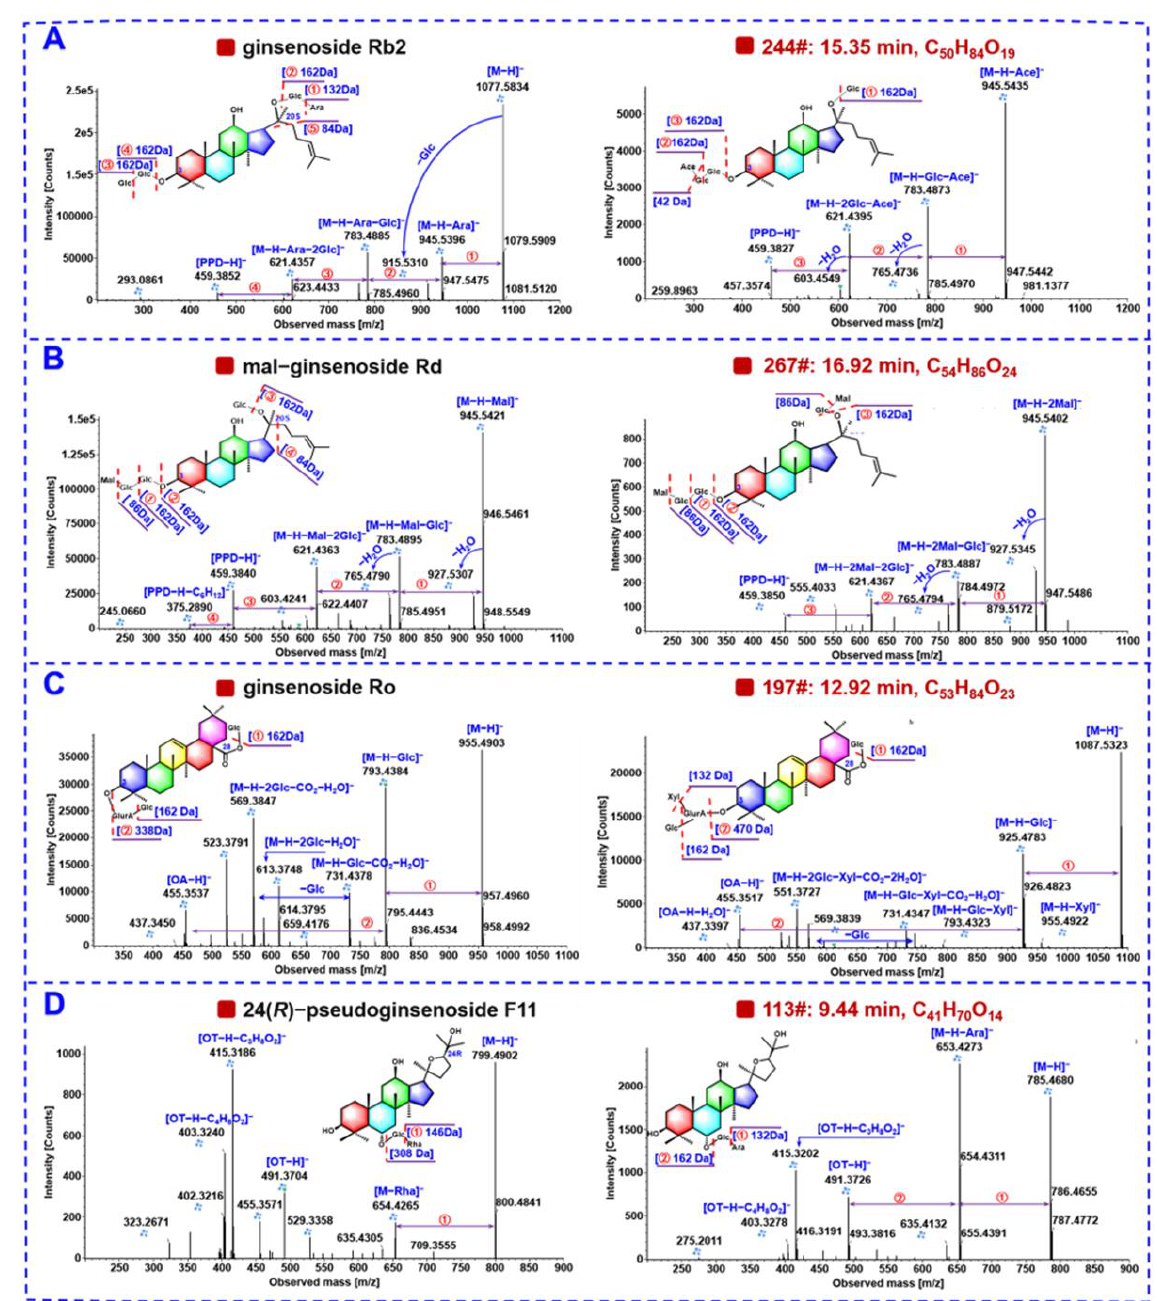
Figure 5. Illustration for characterizing the PPD- ( A ), malonylated ( B ), OA- ( C ), and OT-( D ) type ginsenosides, from PGL/PQL/PNL using the representative compounds.